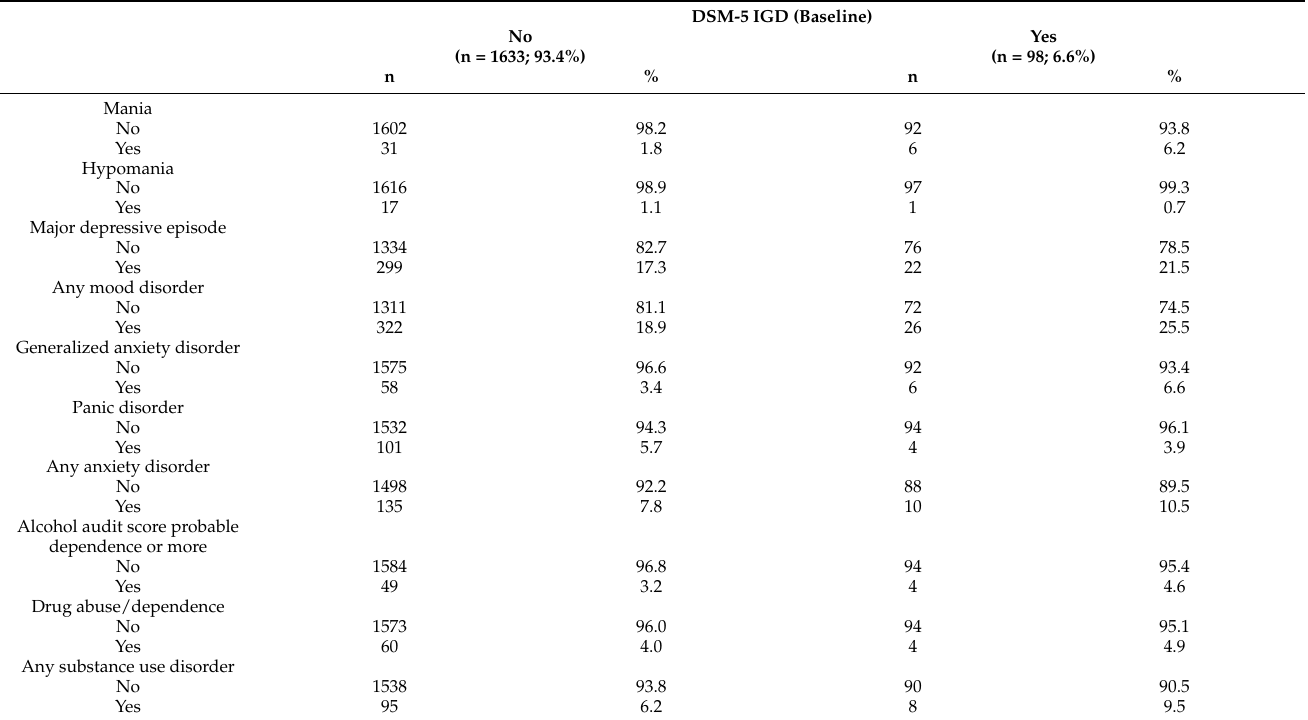
Table 1. Distribution of individual and groups of disorders at follow-up, by baseline Internet Gaming Disorder (n =